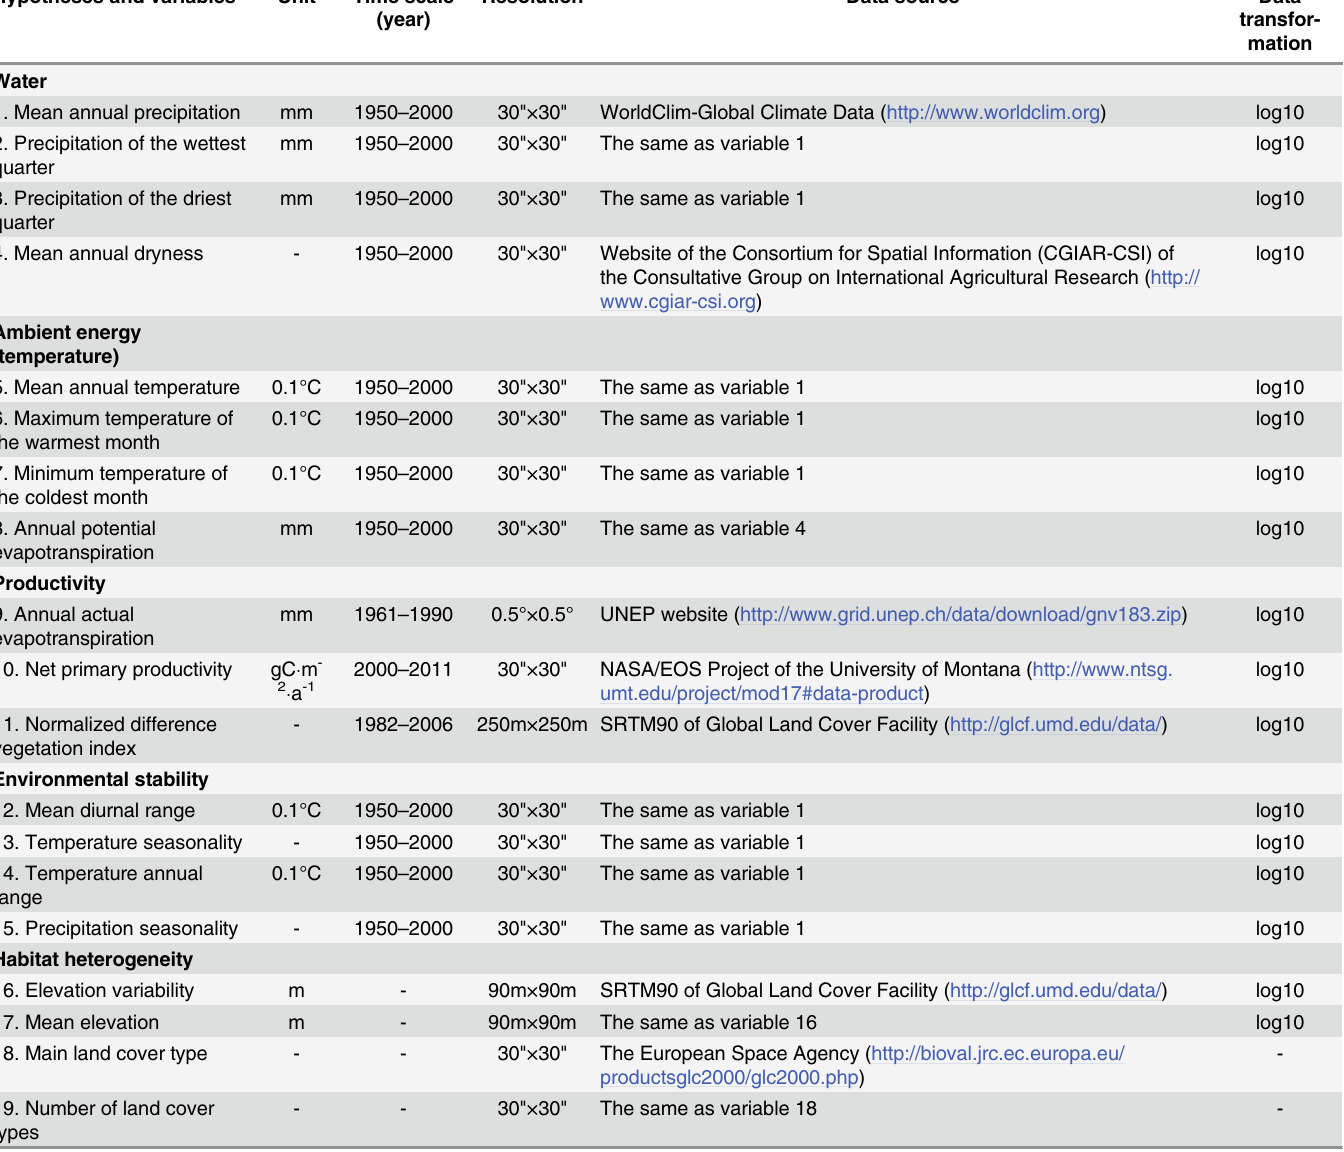
Table 1. Five main hypotheses explaining species richness